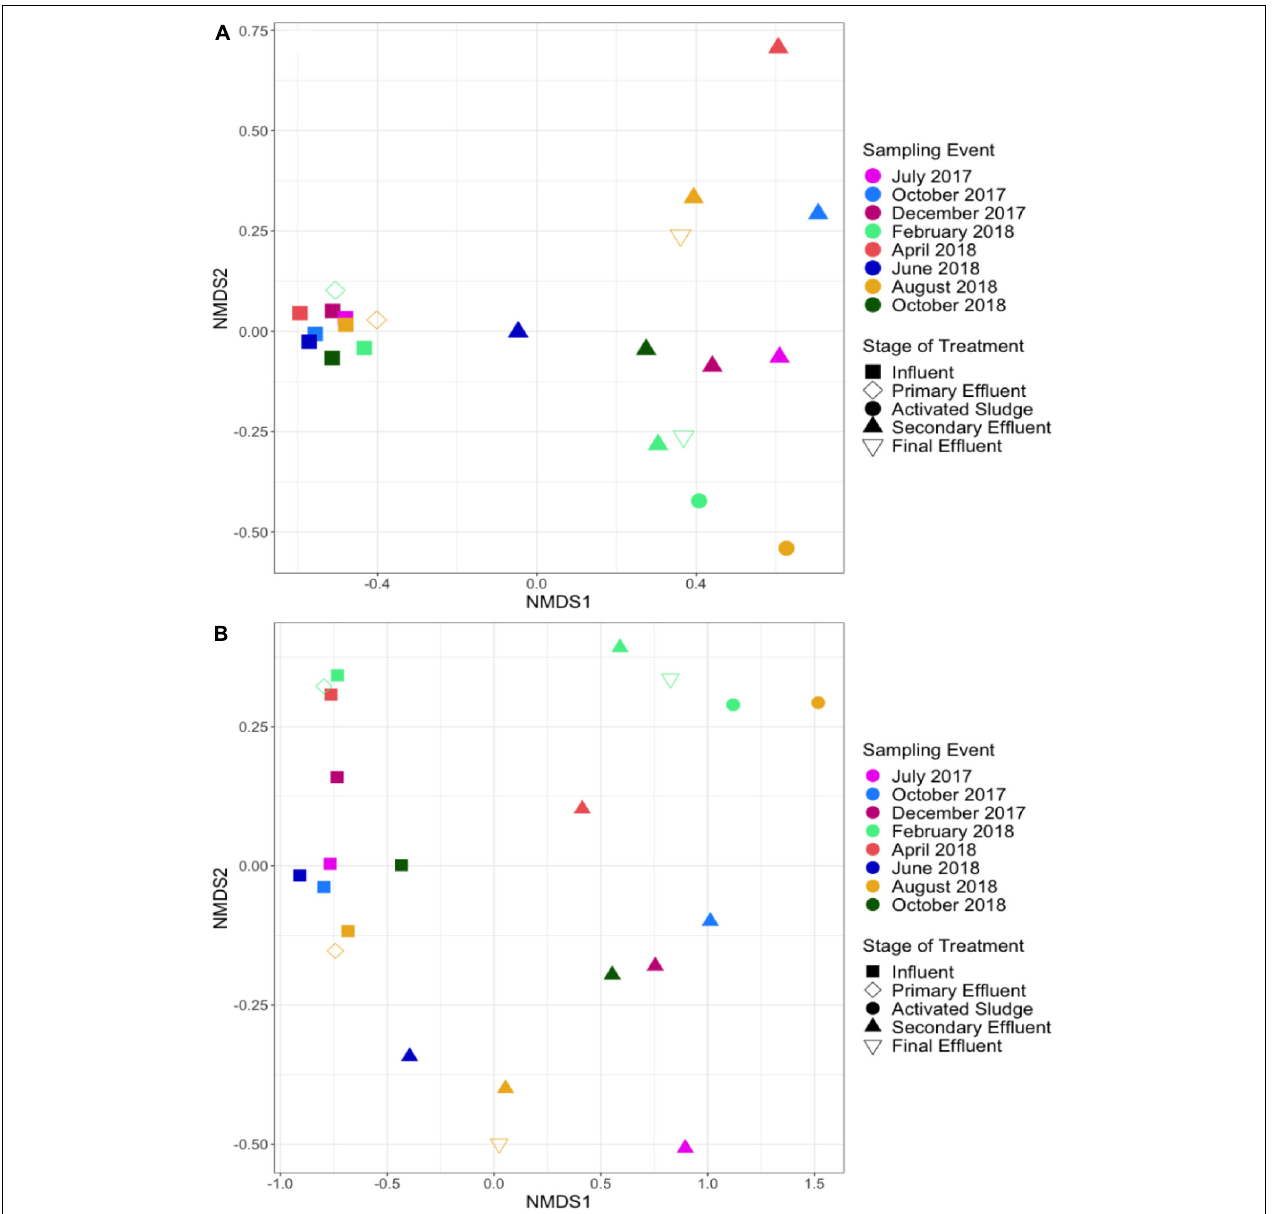
FIGURE 7 | NMDS analysis of (A) ARG profiles (ANOSIM; R = 0.708, p = 0.001) and (B) taxonomic profiles (ANOSIM; R = 0.6547, p = 0.001) across WWTP sampling locations and sampling dates according to shotgun metagenomic sequencing. Influent samples were separated from activated sludge (ANOSIM; R = 1, p = 0.022), secondary effluent (ANOSIM; R = 0.933, p = 0.001), and final effluent (ANOSIM; R = 1, p = 0.022), but not from primary effluent (ANOSIM; R = 0.228, p = 0.178). Secondary and final effluent samples were not separated (ANOSIM; R = –0.306, p = 0.911). ARGs were annotated via CARD (Jia et al., 2017) and the microbiome was annotated via MetaPhlAn2 (Truong et al.,